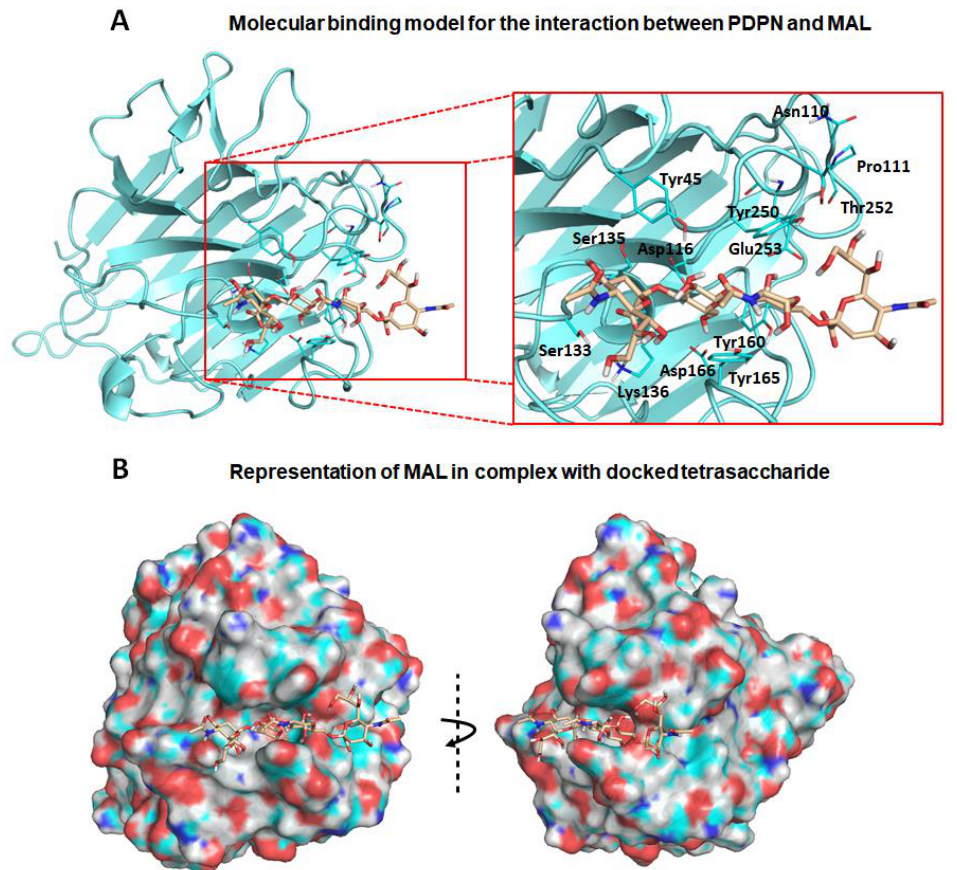
Figure 2. Molecular binding model for the interaction between the PDPN tetrasaccharide 2 and Maackia amurensis seed lectin (MAL): Docked tetrasaccharide 2 (Neu5Ac α (2–3)Gal β -(1–3)[Neu5Ac α (2–6)]GalNAc, in beige) in complex with MAL (cyan). ( A ) Selected residues participating in the main interactions are displayed in sticks and labels and ( B ) surface representation of MAL in complex with docked tetrasaccharide 2. The electrostatic potential is coloured on the surface of the protein from red (negative) to blue (positive).